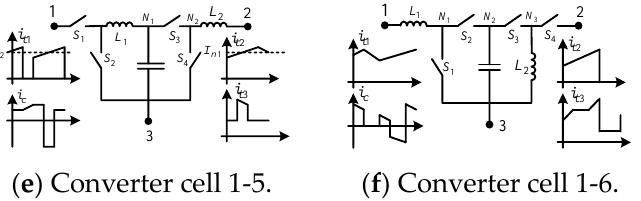
Figure 1. Converter cells that generate a non-pulsed current signal at one terminal and pulsed current signals at two output terminals.